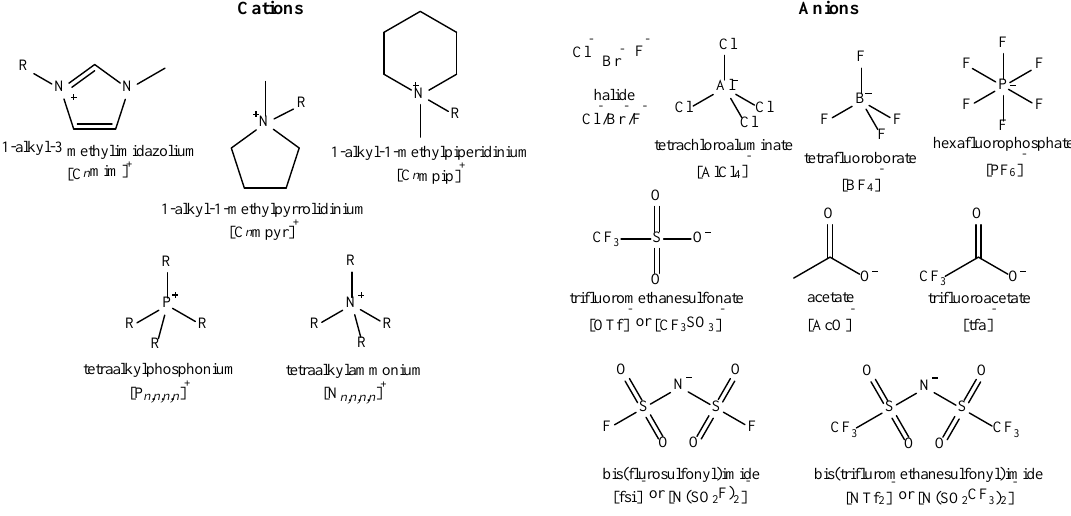
Figure1. Figure 1. Examples of common cations and anions found in ionic liquids, and their preferred abbreviations.